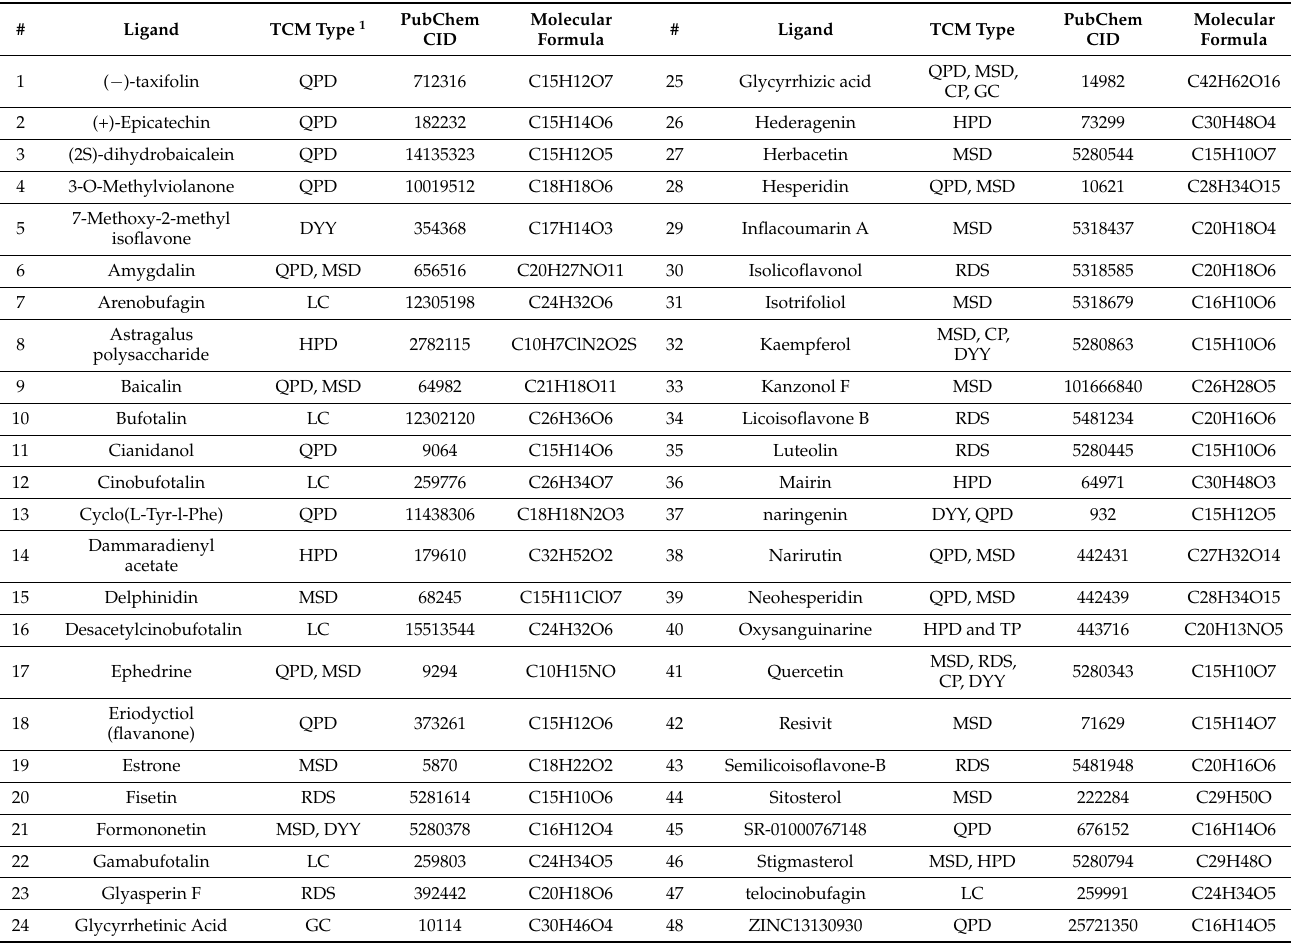
Table 2. Ligands, TCM type, and their PubChem